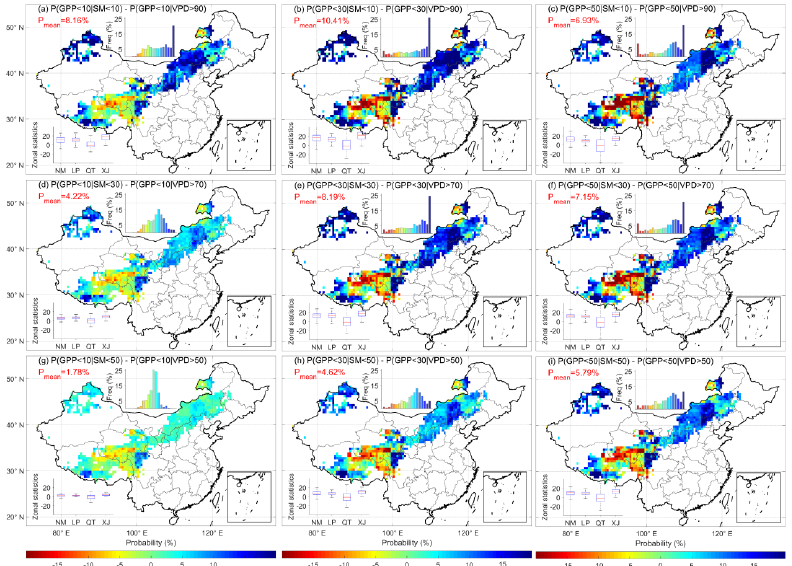
Figure 6. Difference between the probability of ecosystem GPP loss under soil drought conditions minus the probability of ecosystem GPP loss in the atmospheric drought scenario for the historical period. ( a – c ) The difference between the probability of severe, moderate, and mild ecosystem GPP loss corresponding to severe soil drought and atmospheric drought; ( d – f ) the difference between the probability of severe, moderate, and mild ecosystem GPP loss corresponding to moderate soil drought and atmospheric drought; ( g – i ) the difference between the probability of severe, moderate, and mild ecosystem GPP loss corresponding to mild soil drought and atmospheric drought; ( g – i ) the difference in the probability of severe, moderate, and mild ecosystem GPP loss corresponding to mild soil and atmospheric drought.